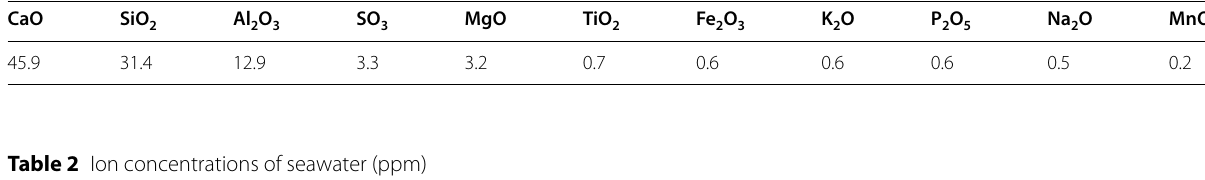
Table 2 Ion concentrations of seawater (ppm) Ca 2 + K + Mg 2 + 420